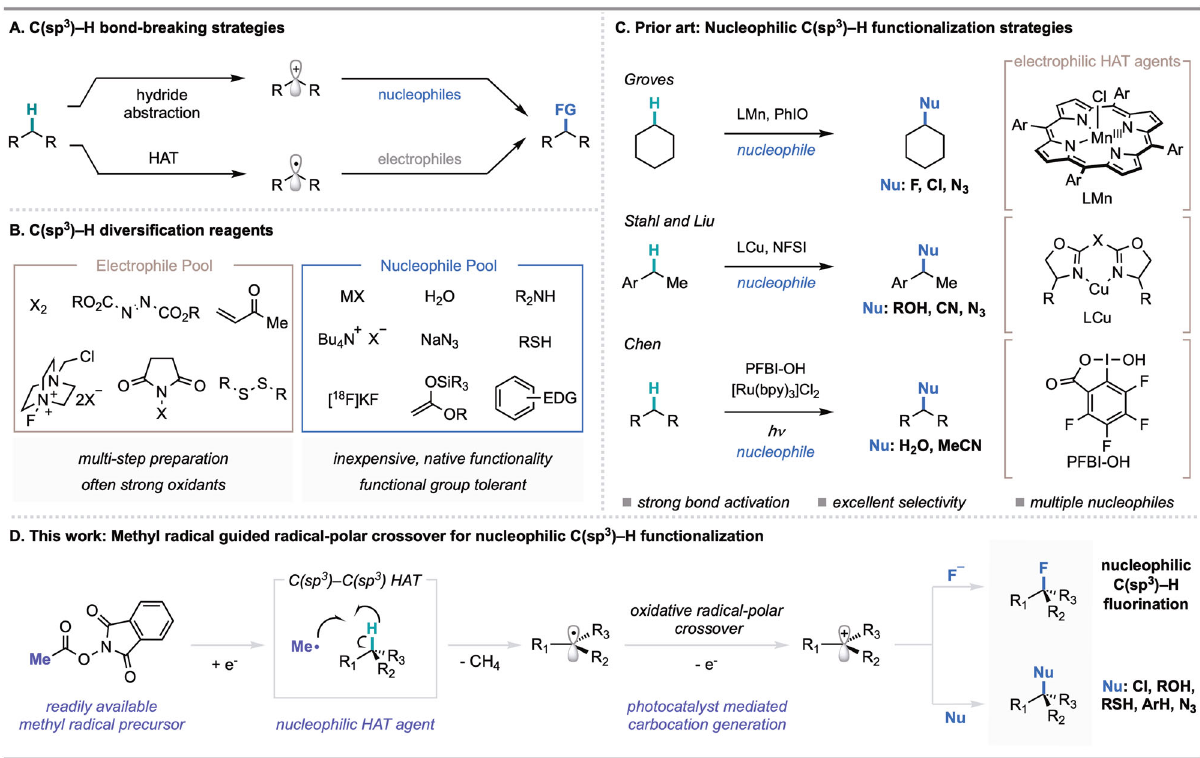
Fig. 1 Prior art in nucleophilic C(sp 3 ) – H functionalization and overview of this work. A Current mechanisms employed for C(sp 3 ) – H activation and subsequent functionalization. B Array of common electrophilic and nucleophilic functionalizing reagents. C Recent examples of nucleophilic C(sp 3 ) – H functionalization 15 – 17,31 – 34 . D This work. HAT = hydrogen atom